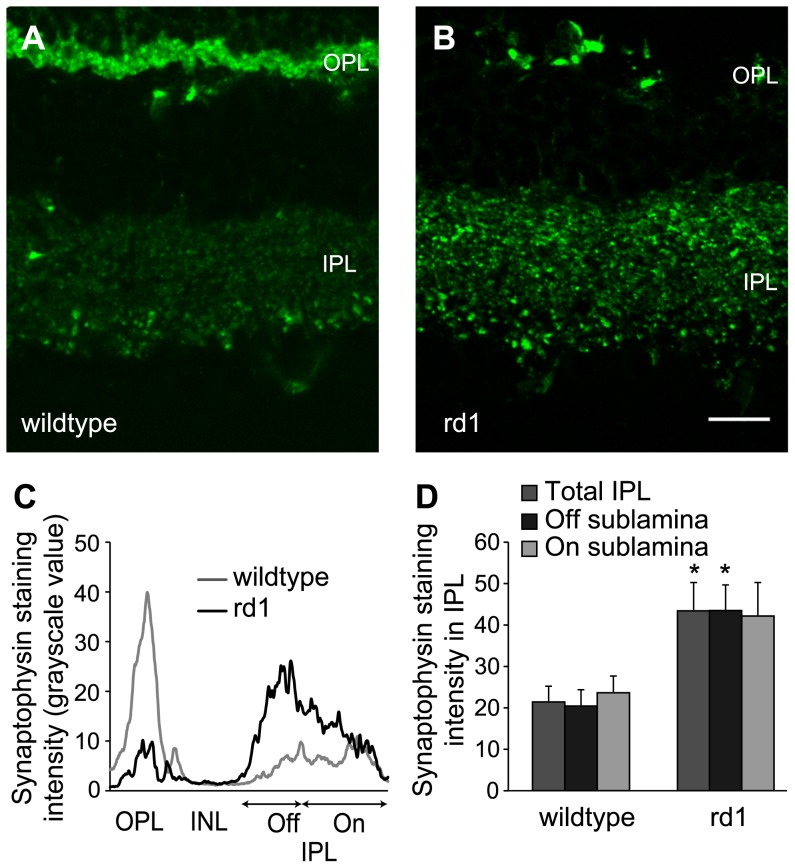
Synaptophysin in the IPL of rd1 mouse was upregulated.A, B) Representative images of vertical sections of adult wild-type (A) and rd1 (B) mouse retinas immunostained for synaptophysin. Scale bar: 50 µm. C) Representative profile of staining intensity through retinal depth covering both plexiform layers of the images shown in A and B. After background subtraction, a line moving vertically from top to bottom across the images measured the signal intensity using Plot Profile function in ImageJ, which is shown here from left to right. Synaptophysin staining is nearly absent in OPL of rd1 mouse retina, whereas that in IPL is higher than in wild-type, particularly in the Off sublamina. D) Levels of synaptophysin in IPL (mean ± SE), measured with quantitative immunohistochemistry were significantly higher in adult rd1 mouse retina than in wild-type (p = 0.018; n = 6). Within IPL, the levels were significantly higher in Off sublamina (p = 0.01), but not in On sublamina (p = 0.068). The data shown here are essentially the area under the curve for On (60% of IPL) and Off (40%) sublaminas shown in 2C. *p<0.05.